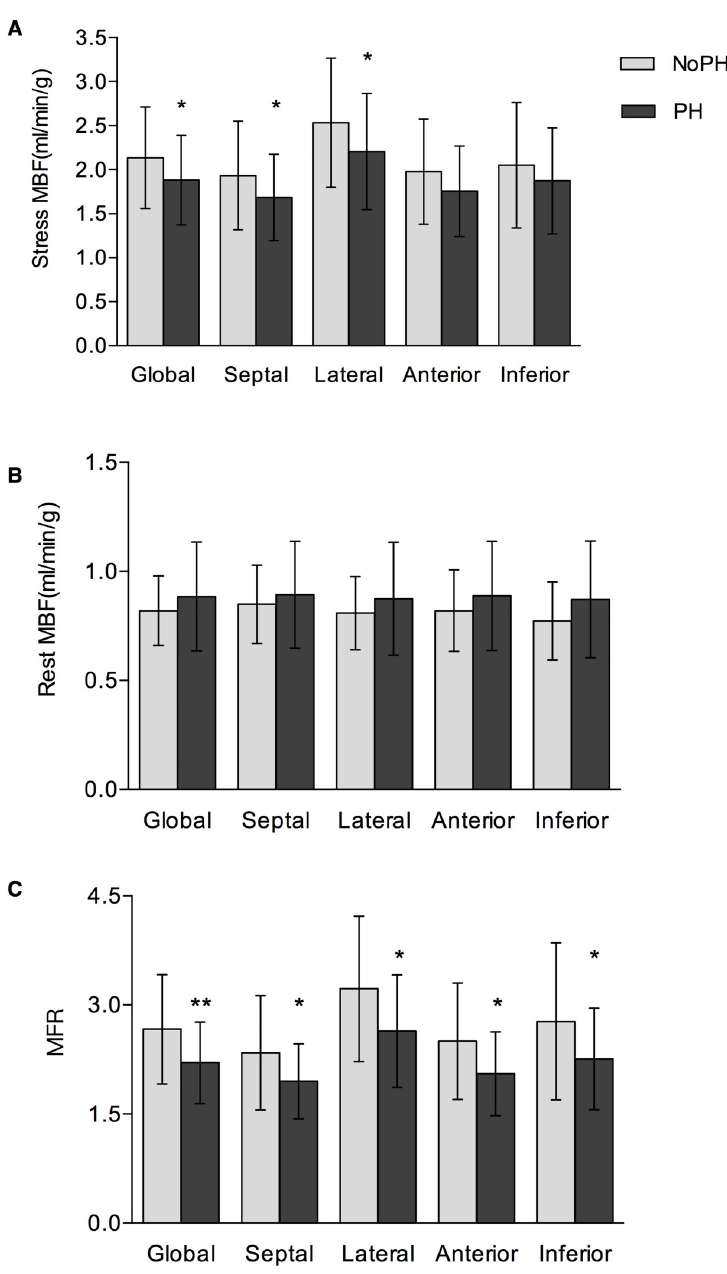
Fig 2. Comparison of global and regional MBF/ MFR between HCM patients with and without PH. A: stress MBF; B: rest MBF; C: MFR. � p < 0.05, �� p < 0.01 for comparison between PH versus no PH.